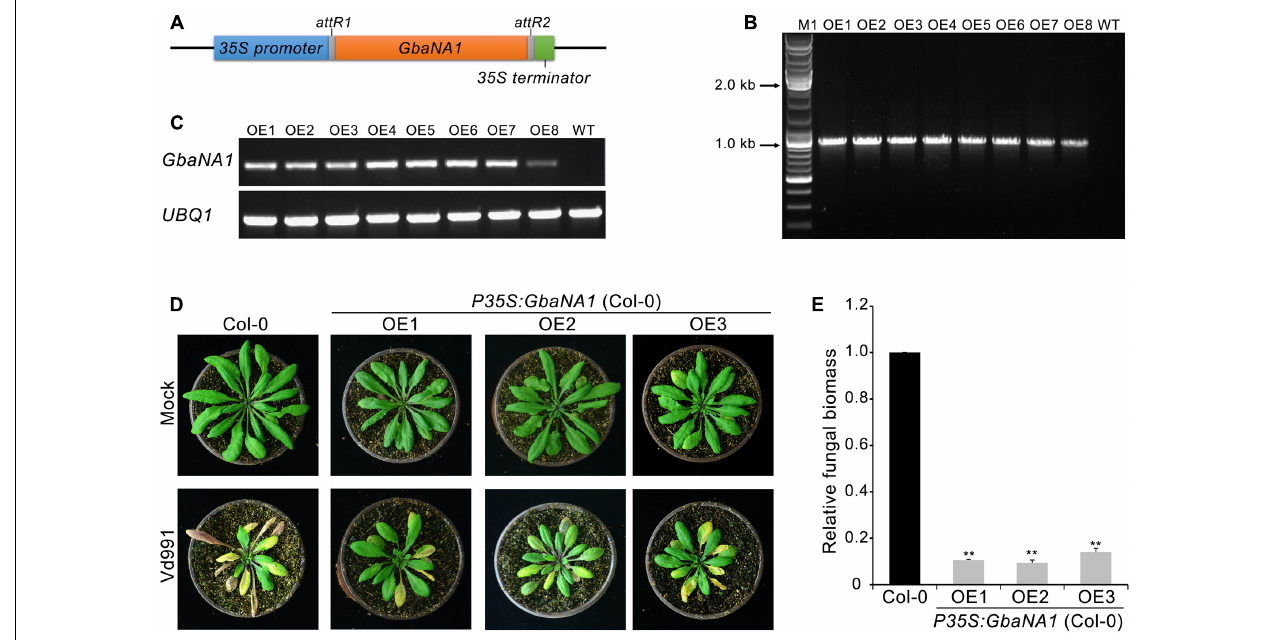
FIGURE 1 | Transgenic expression of GbaNA1 enhances Verticillium wilt resistance in Arabidopsis thaliana . (A) Diagram of the GbaNA1 -overexpressing transformation vector pFAST:GbaNA1. (B) PCR products targeting a fragment of GbaNA1 amplified from DNA extracted from GbaNA1 -overexpressing transgenic lines of A. thaliana ecotype Col-0. (C) RT-PCR amplification of GbaNA1 cDNA in the same transgenic A. thaliana . UBQ1 is shown as a control. (D) Phenotype assay of GbaNA1 transgenic A. thaliana inoculated with V. dahliae , strain Vd991. A. thaliana plants were engineered to express cotton CaMV 35S-driven GbaNA1 ( P35S:GbaNA1 ). Three-week-old seedling of wild-type (Col-0) and transgenic lines (OE1, OE2, and OE3) inoculated with V. dahliae strain Vd991 via root-dipping in a suspension of 5 × 10 6 conidia/mL or sterile water (Mock). Disease symptoms were observed 21 days after inoculation. (E) Quantification of V. dahliae biomass in GbaNA1 transgenic A. thaliana plants (OE1, OE2, and OE3) compared to the wild-type (Col-0). Relative fungal biomass was determined using quantitative real-time PCR and genomic DNA extracted from total plants of three plants 21 days after inoculation. V. dahliae elongation factor 1- α ( EF-1 α ) was used to quantify fungal colonization, and A. thaliana UBQ1 was used as endogenous plant control. Error bars represent standard errors of three biological replicates, ∗∗ indicates statistical significance ( P < 0.01), according to unpaired Student’s t